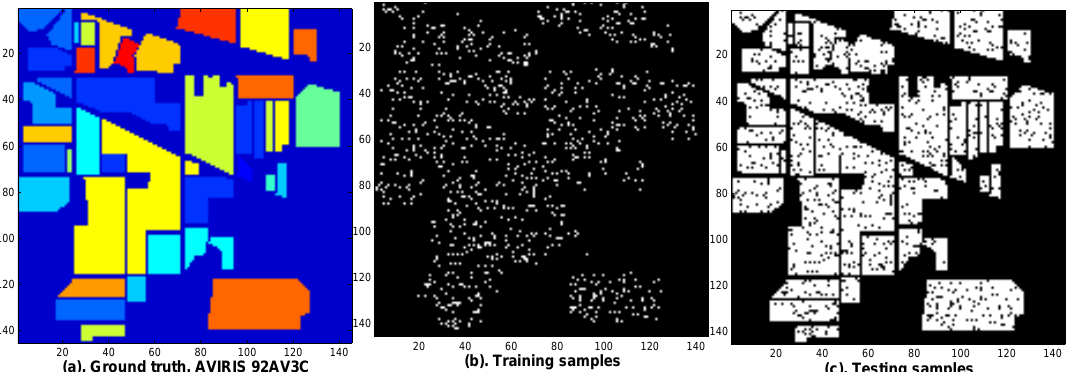
Figure 11. Illustration of AVIRIS 92AV3C dataset: ( a ) ground truth; ( b ) distribution of training samples; ( c ) distribution of testing samples.